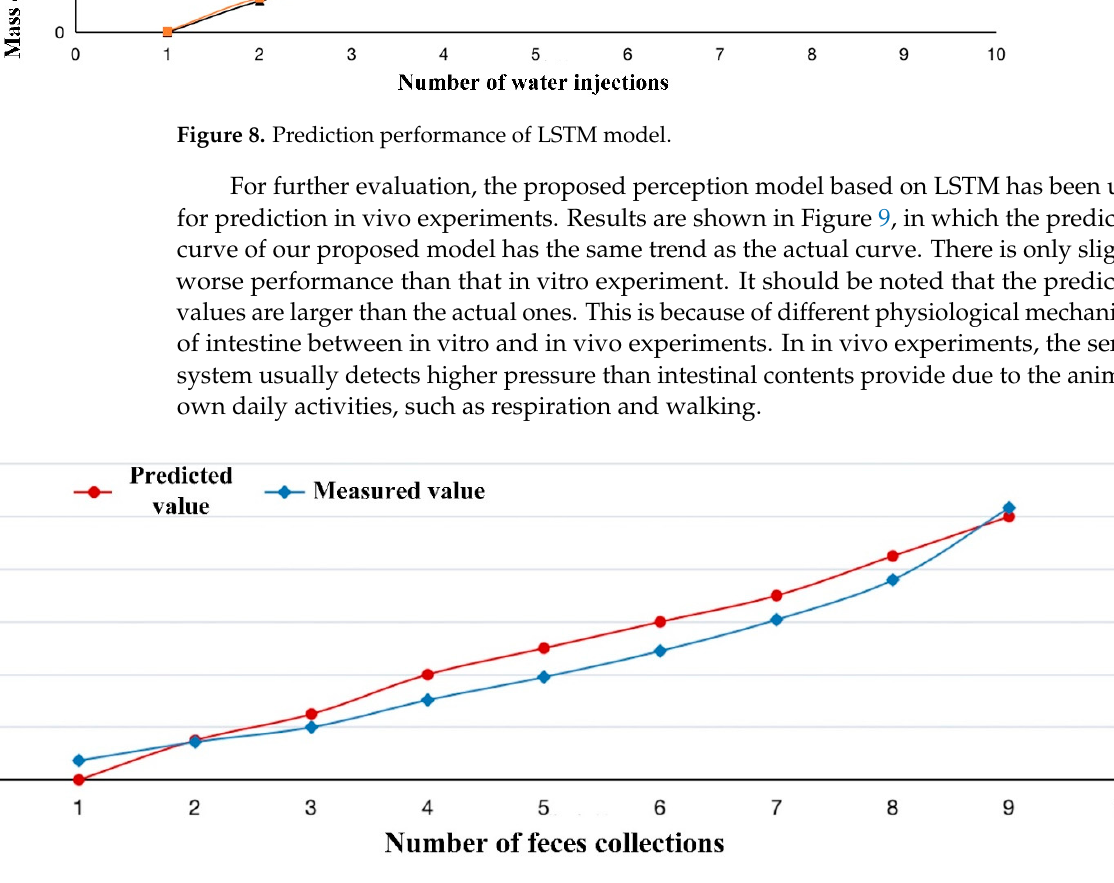
Figure 8. Prediction performance of LSTM model.